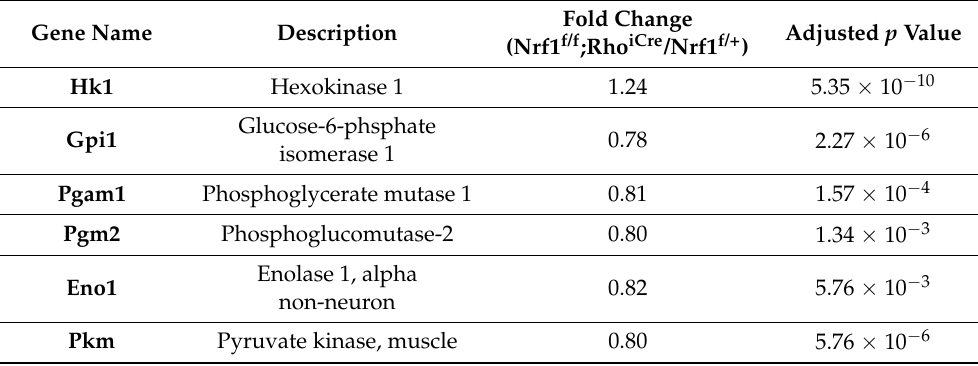
Table 4. Genes involved in glycolysis pathway with altered expression in Nrf1 f/f ; Rho iCre